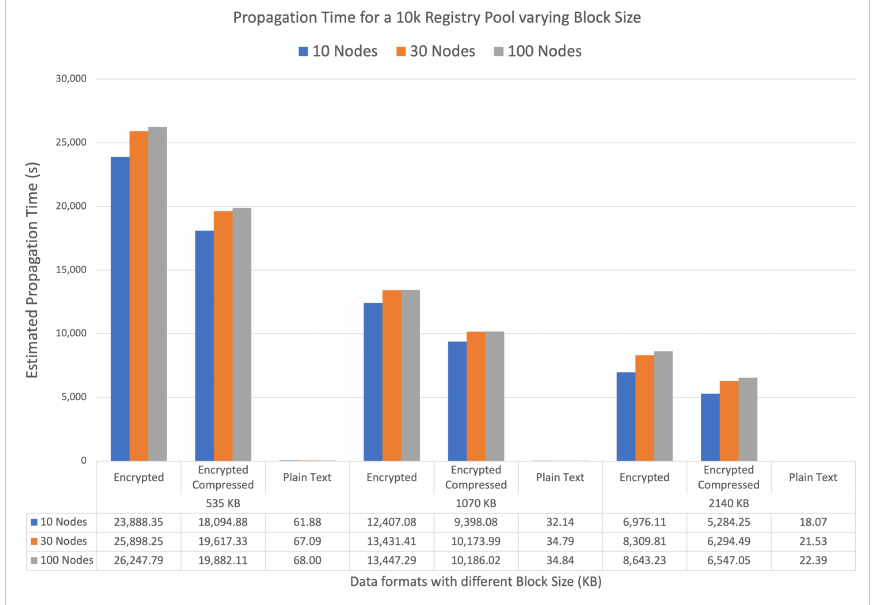
Figure 7. Blockchain network simulation: 10,000 pool size with block header of 500 B and block time of 5 s. Different scenarios compare different block sizes (535, 1070, and 2140 KB) in three formats (plain text, encrypted cyphertext, and compressed and encrypted cyphertext) with 10, 30, and 100 nodes distributed in three different regions. The chart depicts the time in seconds for 10,000 registries to propagate in the